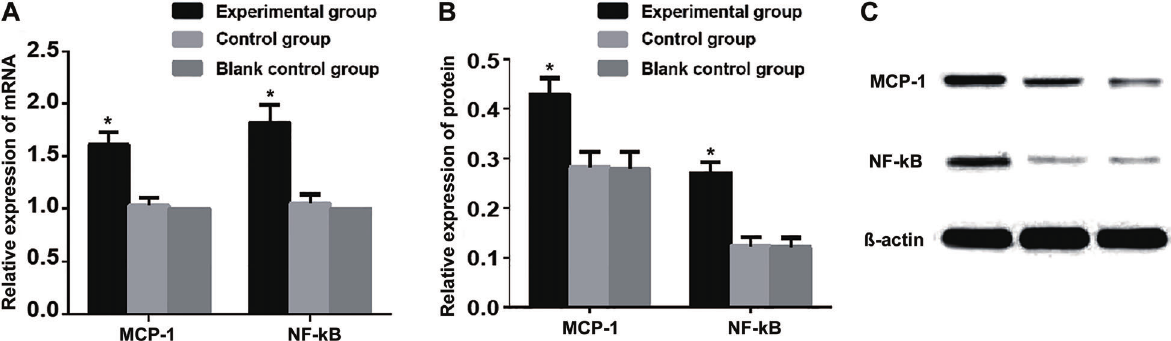
Figure 2. A , Relative mRNA expression (%) of monocyte chemotactic protein 1 (MCP-1) and nuclear factor kappa B (NF- k B) among the spinal tuberculosis (experimental), sham operated (control) and blank groups. B , Protein expressions (%) of MCP-1 and NF- k B among the same groups. C , Western blotting of the protein expressions of MCP-1 and NF- k B. *P o 0.05 compared to the blank and sham groups